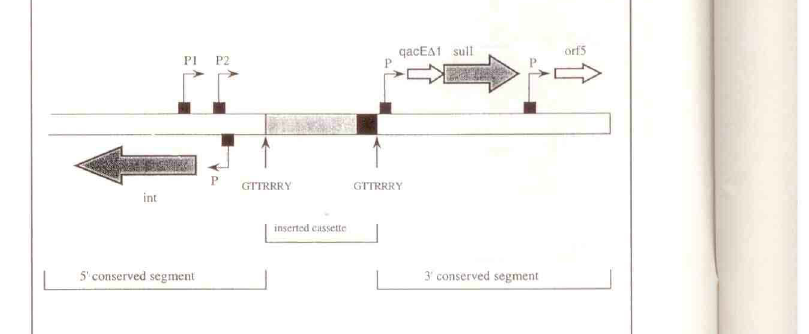
Figure 2) Structure ef an integron. A variable central region carries one or more cassettes, each with a palindromic '59-base element' at its downstream end. Promoter P 1 occurs in versions ef differentJorce due to sequence po{ymorphisms in the -35 and - JO boxes. In some inte grons, an insertion qf three guanine residues changes the spacing